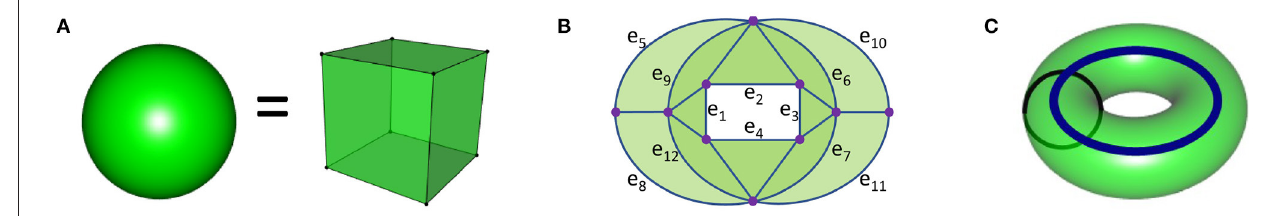
FIGURE 1 | (A) The solid ball and solid cube are topologically equivalent and thus have the same homology. Their surface boundaries also have the same homology since these surfaces are topologically equivalent. The solid ball has one connected component and thus β 0 = 1. The solid ball does not contain any voids, and thus β i = 0 for all i > 0. The sphere, which is the boundary of the ball, has β 0 = 1 since it is connected, and β 2 = 1 since the 2-dimensional sphere bounds a void, while β i = 0 for all other i since there are no lower or higher dimensional voids. For an n + 1-dimensional ball (for example, all points of distance less than or equal to 1 from the origin in R n + 1 ), β i = 0 for all i > 0 since it does not contain any voids. The n -dimensional sphere, which is the boundary of the n + 1-dimensional ball, has β i = 1 for i = 0, n and β i = 0 for all other i . Since the n -dimensional sphere contains a void, it is the n -dimensional object that generates β n . (B) A surface with boundary that is topologically equivalent to an annulus. The annulus is a 2-dimensional surface that has the same homology as a 1-dimensional circle. Since this object has one connected component, β 0 = 1. We can use addition to represent a cycle. The cycle e 5 + e 9 + e 12 + e 8 = e 5 + e 8 + e 9 + e 12 is homologous to 0 since it bounds a surface (the light green waning crescent moon). Since all 1-dimensional cycles are either homologous to 0 or to (a multiple of) the rectangle cycle e 1 + e 2 + e 3 + e 4 , β 1 = 1. Since this object lives in the 2-dimensional plane, β i = 0 for all i > 1. (C) The solid torus has β i = 1 for i = 0,1 and β i = 0 for all other i while its boundary, the torus, has β i = 1 for i = 0,2, β 1 = 2, and β i = 0 for all other i . The thick blue cycle is a 1-dimensional homology generator for both the solid torus and its boundary. The thiner black cycle is a homologous to 0 in the solid torus as it bounds a meridinal disk, while this black circle is a homology generator in the torus which is not homologous to the blue circle. The torus surface generates the 2-dimensional homology.